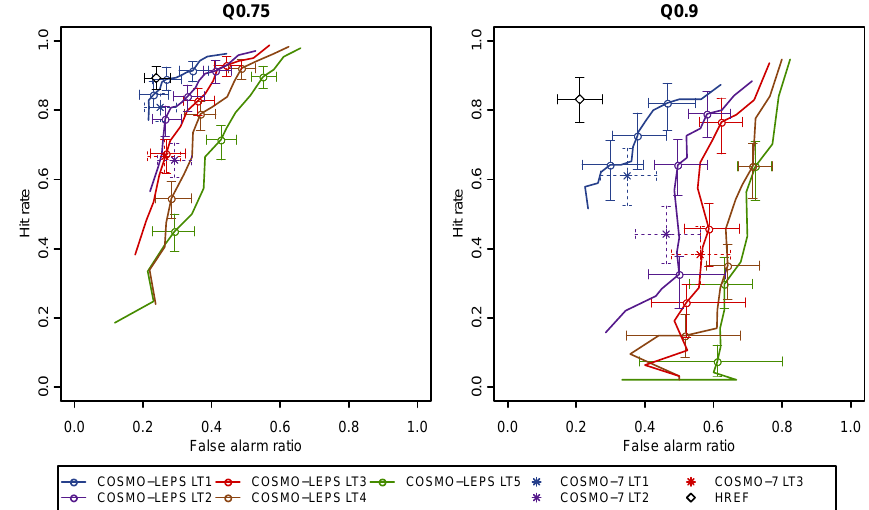
Fig. 6. False alarm ratio and hit rate for the daily maximum Sihl discharge in Zurich for the discharge thresholds Q 0 . 75 (left) and Q 0 . 9 (right) and for lead times (LT) of 1 to 5 days. The lines refer to COSMO-LEPS-based forecasts and their circles correspond to the probability thresholds 25%, 50% and 75% (from right to left). The diamonds and stars indicate the performance of HREF and COSMO-7-based forecasts, respectively. The raw scores are exhibited by the symbols (circles, diamonds and stars), while the extremities of the confidence intervals consist of the 5th and 95th percentiles derived by